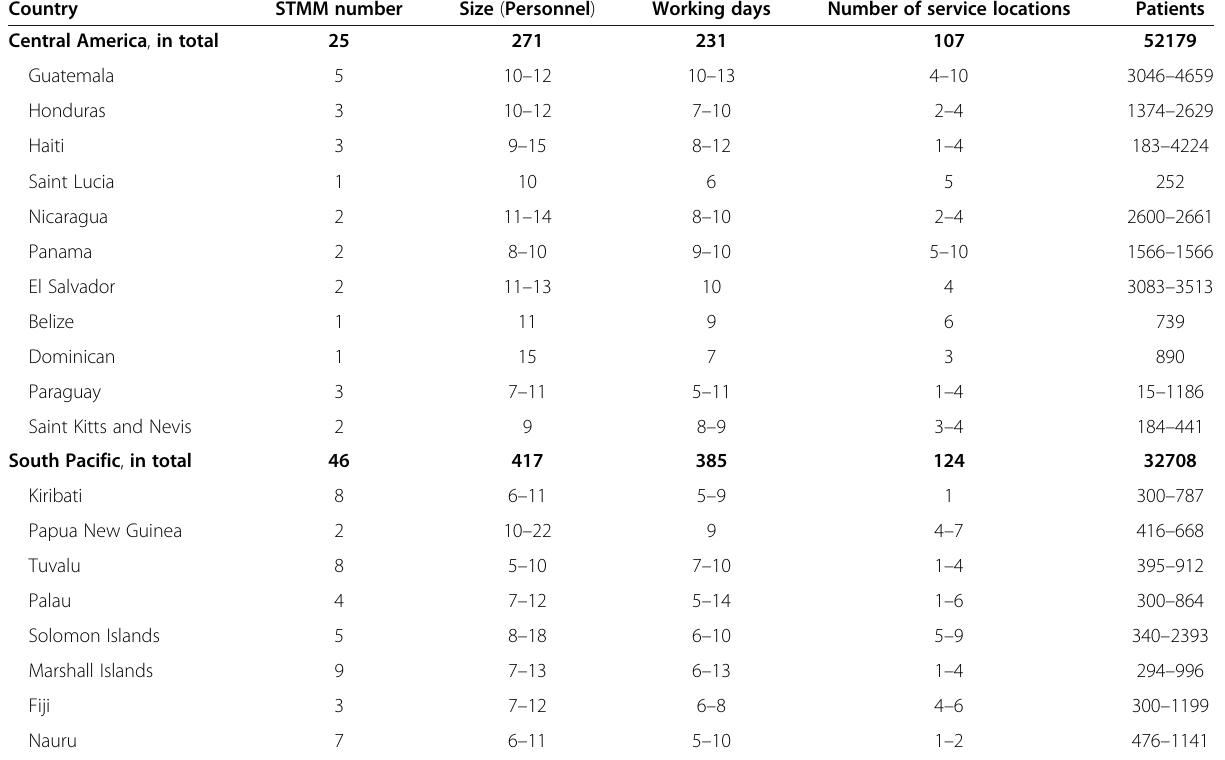
Table 3 Structure of STMMs dispatched to the South Pacific and Central America Country STMM number Size ( Personnel ) Working days Number of service locations Central America , in